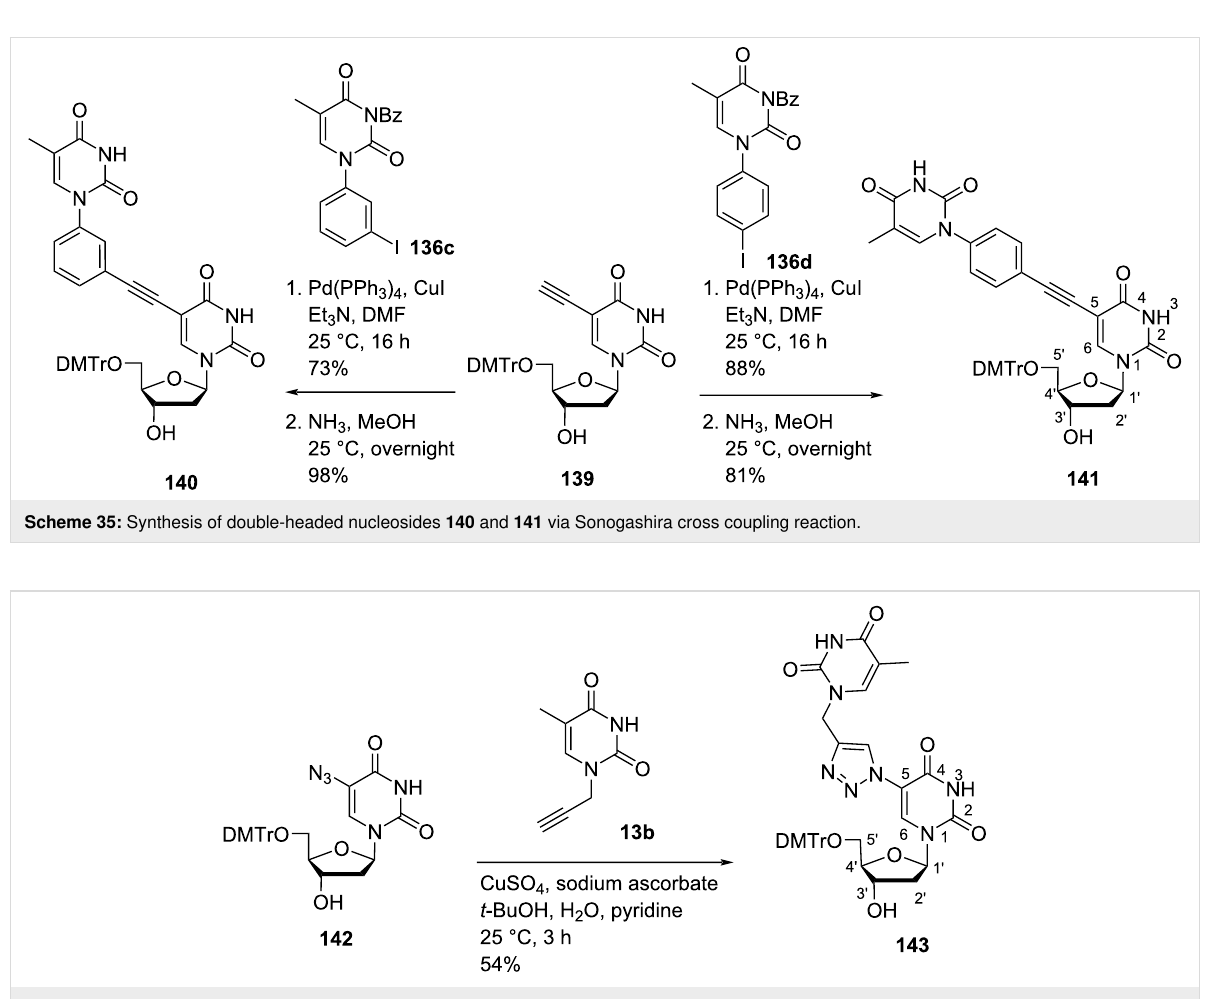
Scheme 36: Synthesis of double-headed nucleoside 143